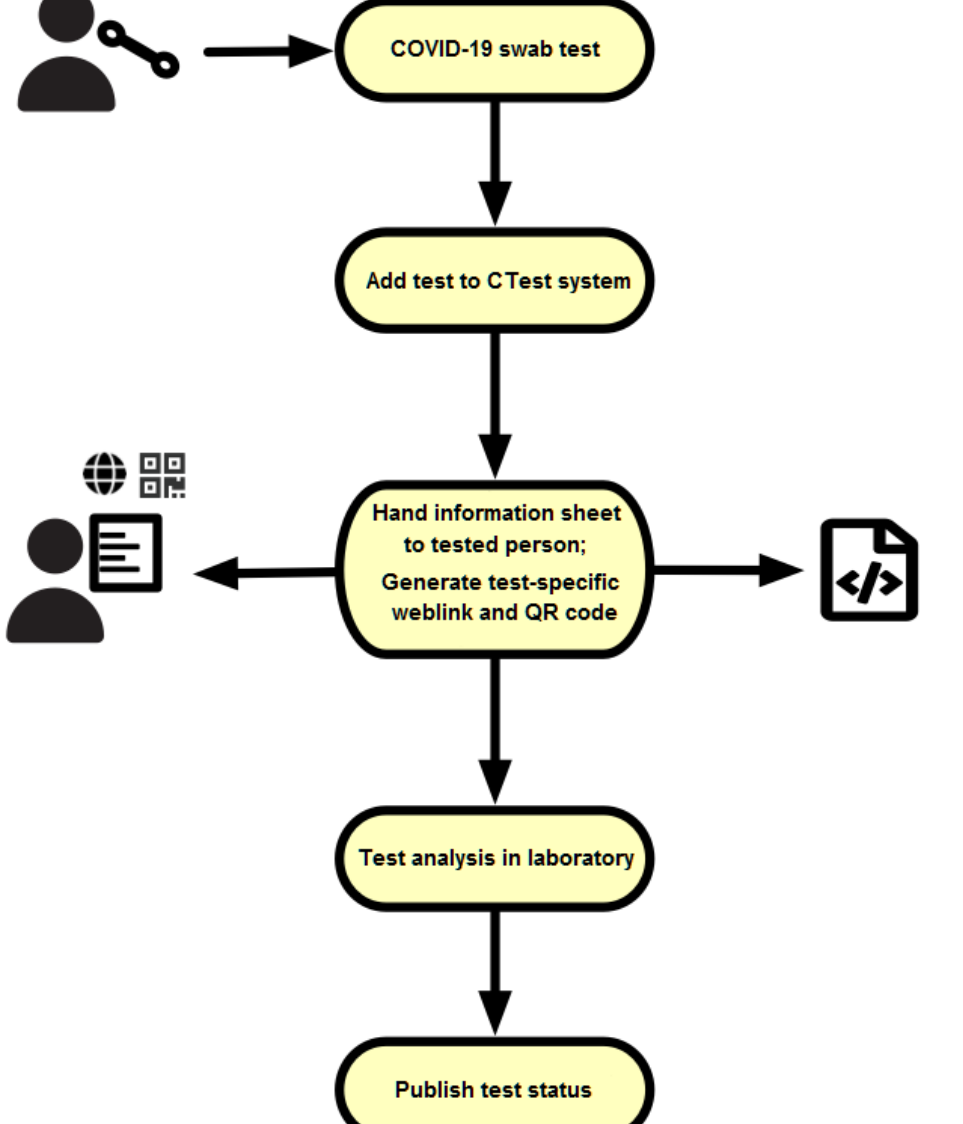
Figure 1. Workflow of the COVID-19 test process using CTest. First, a COVID-19 swab test is performed. The test is then added to the CTest system via an order number. Based on this order number, CTest generates a cryptographically secure tracking ID. An information sheet with a test-specific weblink and QR (Quick Response) code is generated by CTest and handed over to the person tested. After laboratory analysis is complete, the results are sent to CTest. CTest updates the test results, which can be queried via the individual